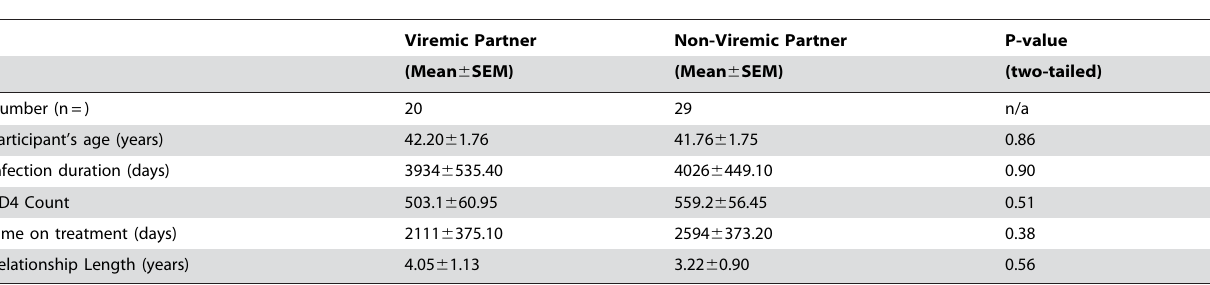
Table 1. Clinical parameters of each study